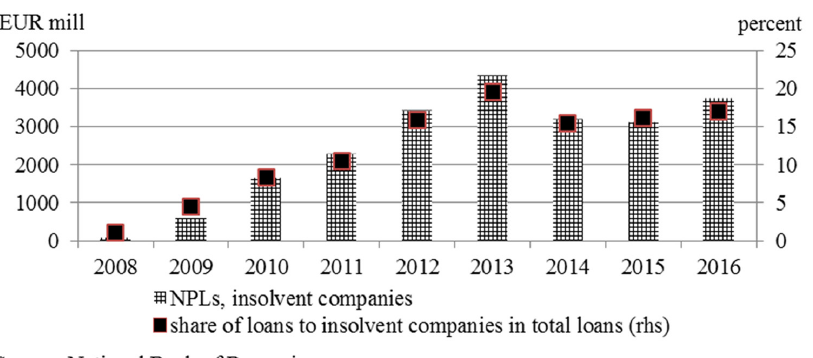
Figure 1. Non-performing loans generated by insolvent